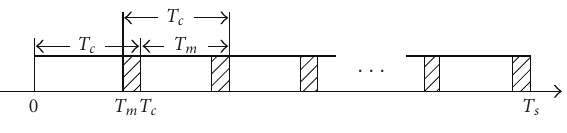
Figure 3: Illustration of overlapping